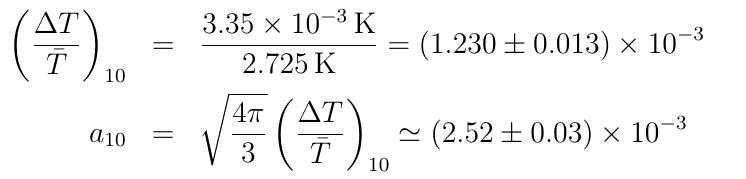
Figure 13 for various values of the inhomogeneity scale r measured CMB dipole (dashed line) [156]: